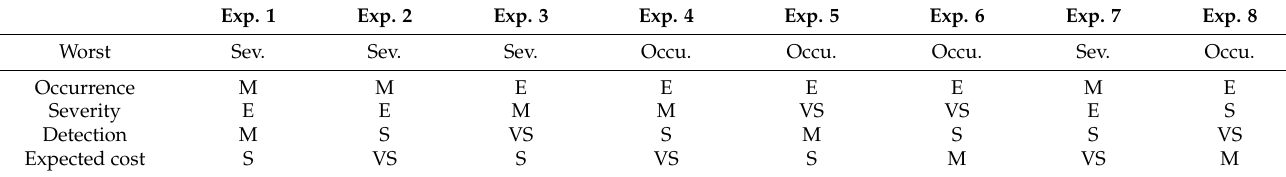
Table 6. Importance of the worst criterion over all the criteria.